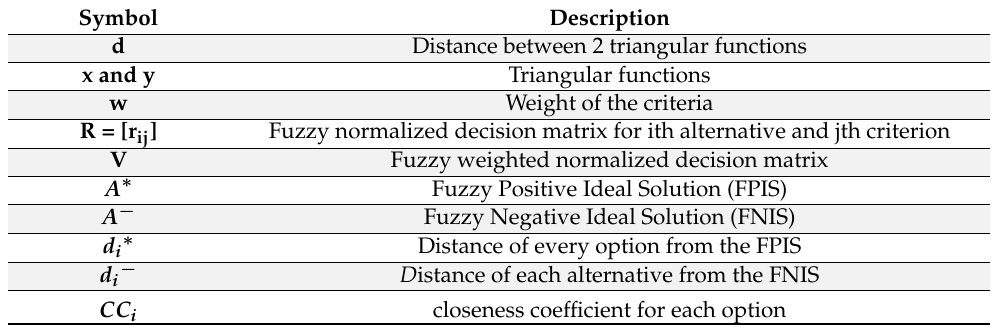
Table 2. Notations list.